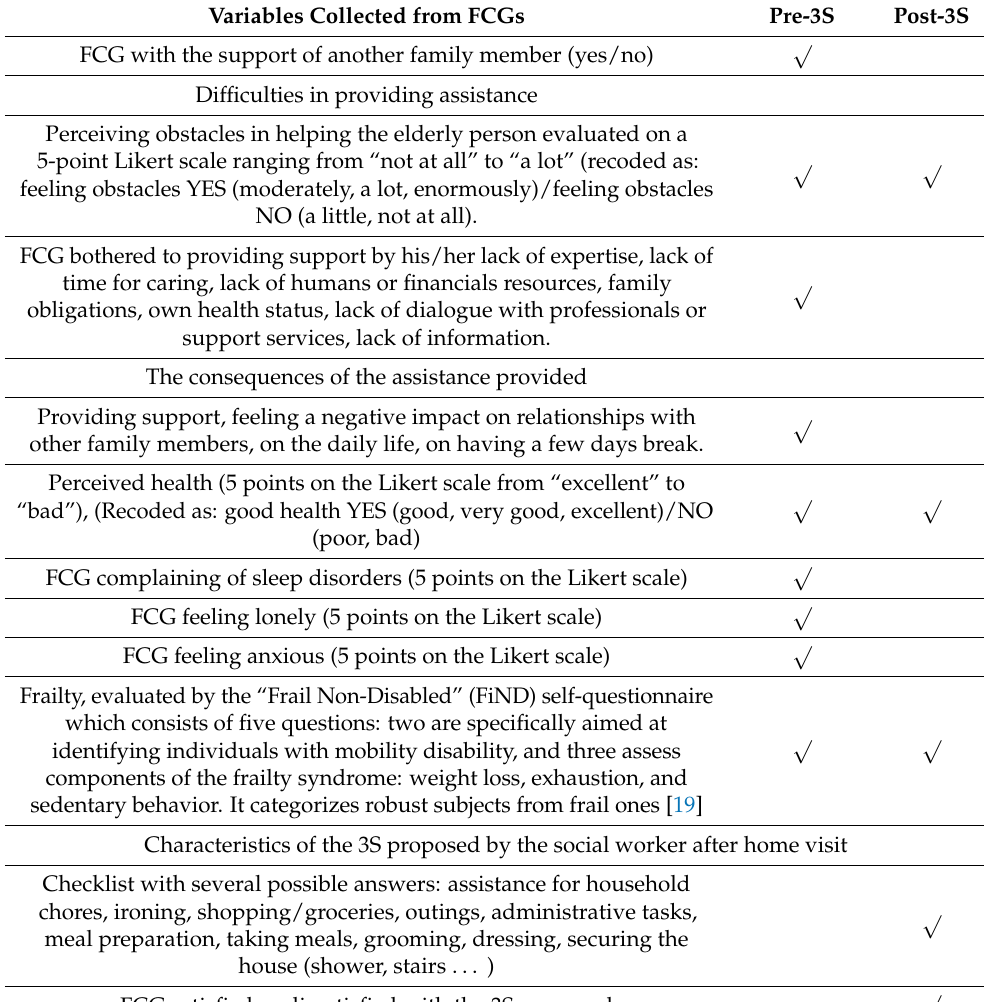
Table 1. Cont. Variables Collected from FCGs Pre-3S Post-3S FCG with the support of another family member (yes/no)